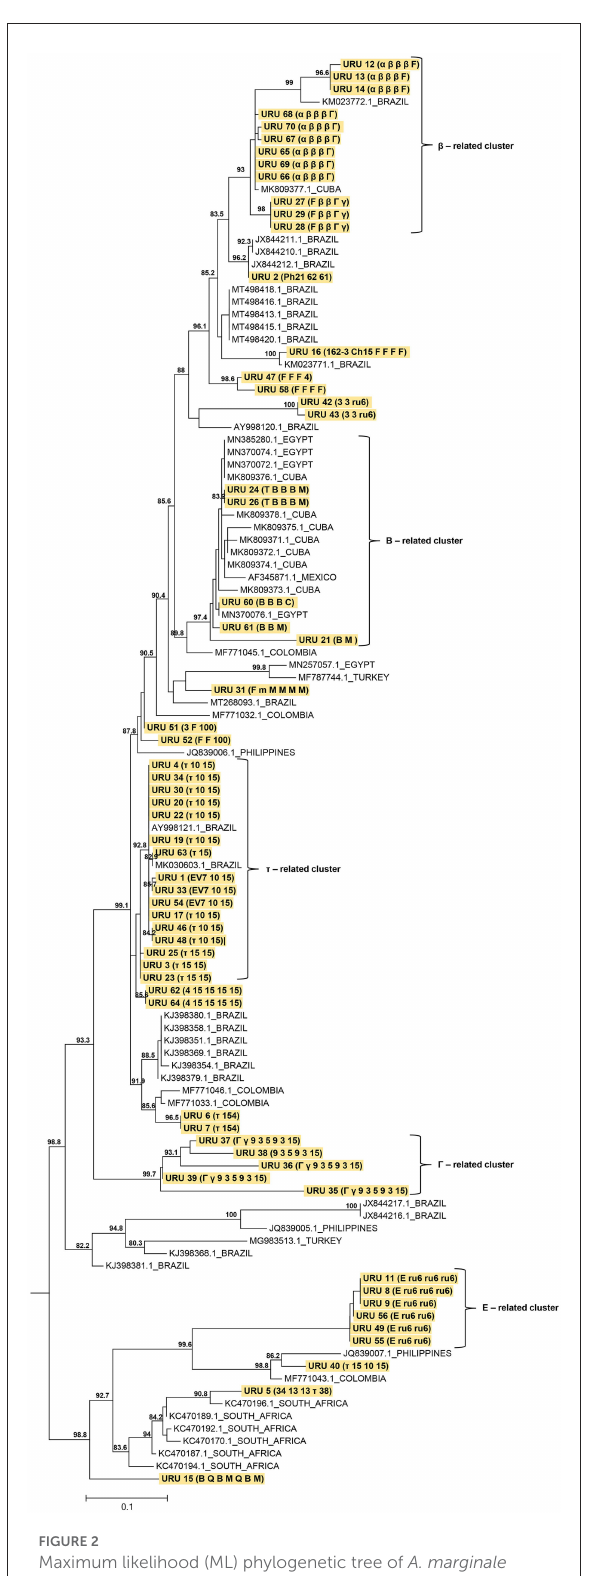
FIGURE2 Maximum likelihood (ML) phylogenetic tree of A. marginale strains based in partial MSP1a amino acid sequences.